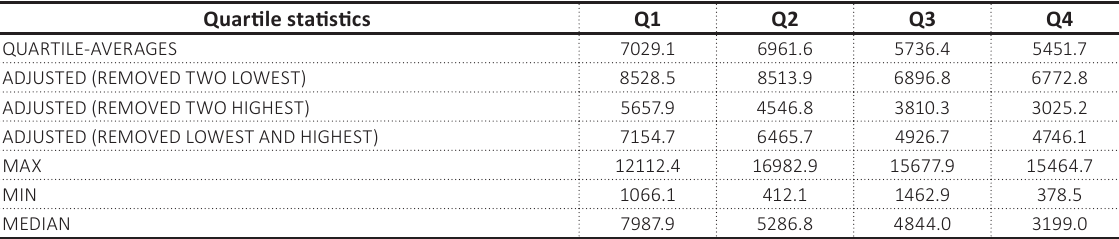
Table 1. Quartile statistics for the turnover-per-trade (2018)* Quartile statistics